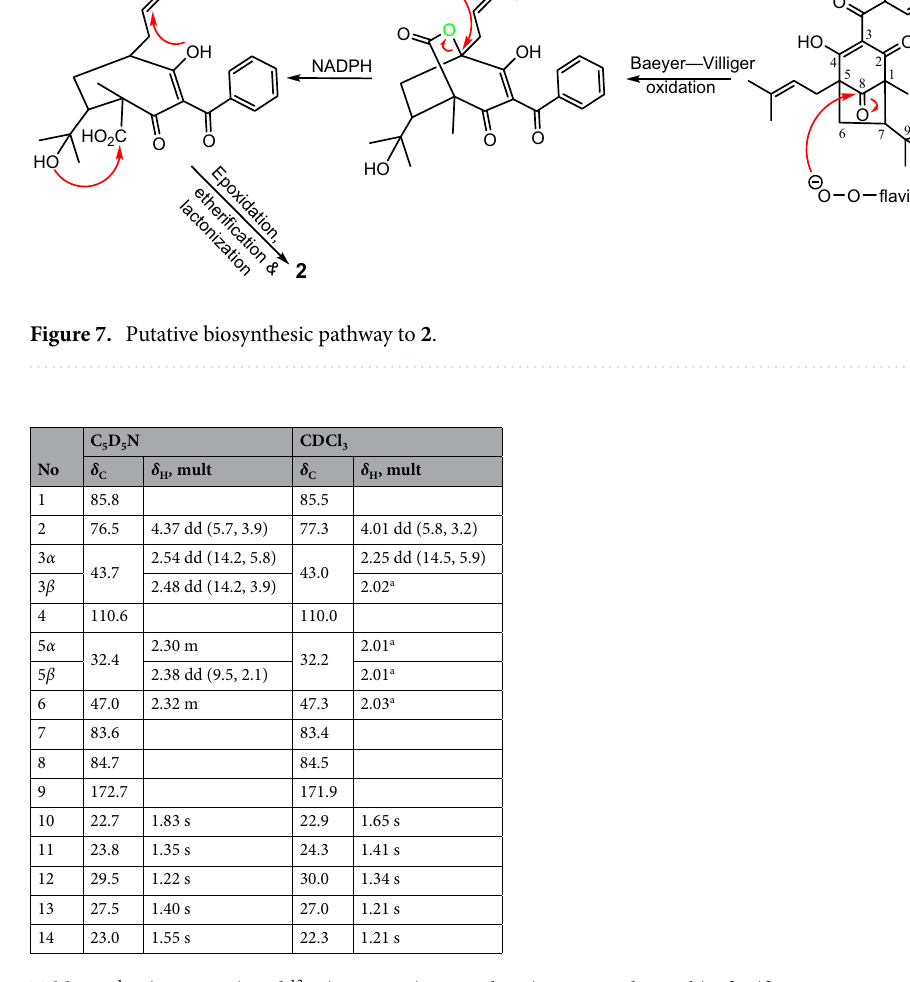
Table 2. 1 H (500 MHz) and 13 C (125 MHz) NMR data (C 5 D 5 N and CDCl 3 ) of 3 ( δ in ppm, J in Hz). a Overlapping